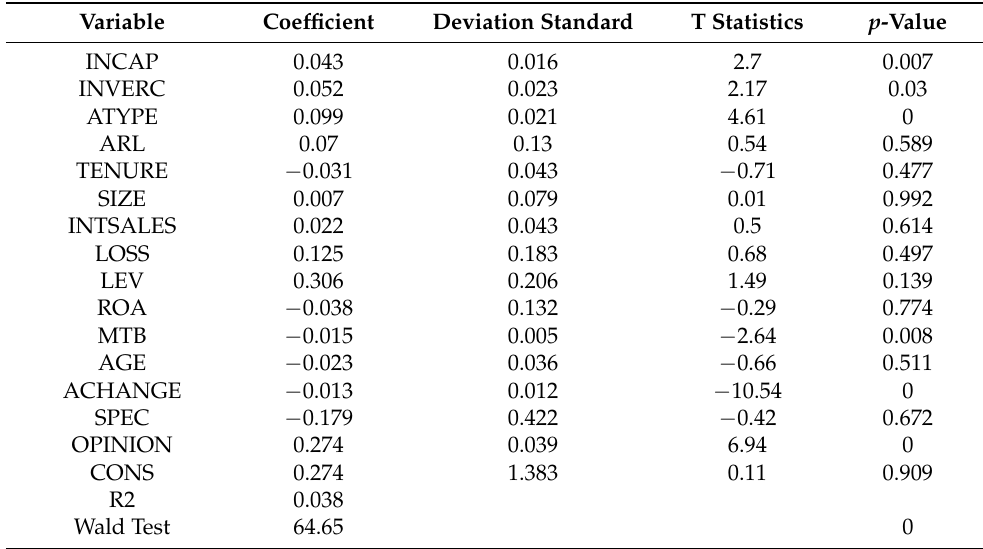
Table 8. The results of estimating the second model by the method of fixed effects.